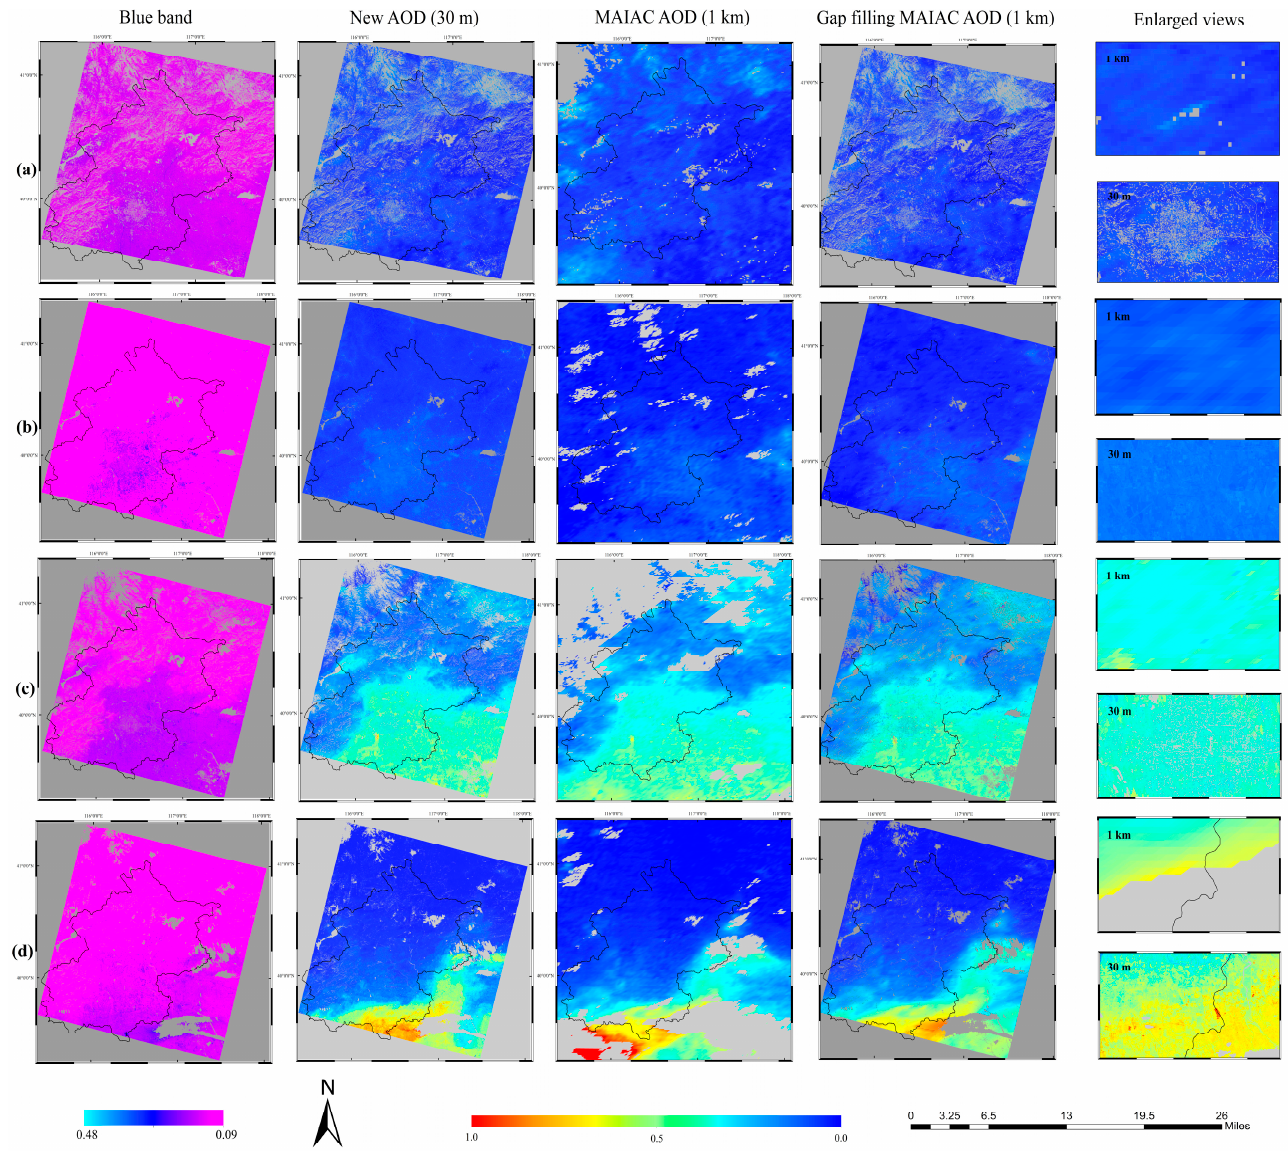
Figure 7. Spatial distribution of the Landsat-7 ( a ) and Landsat-8 ( b – d ) blue band atmosphere datasets, the new (30 m) AOD datasets from this study, the MAIAC datasets (1 km), and enlarged views of Beijing of different